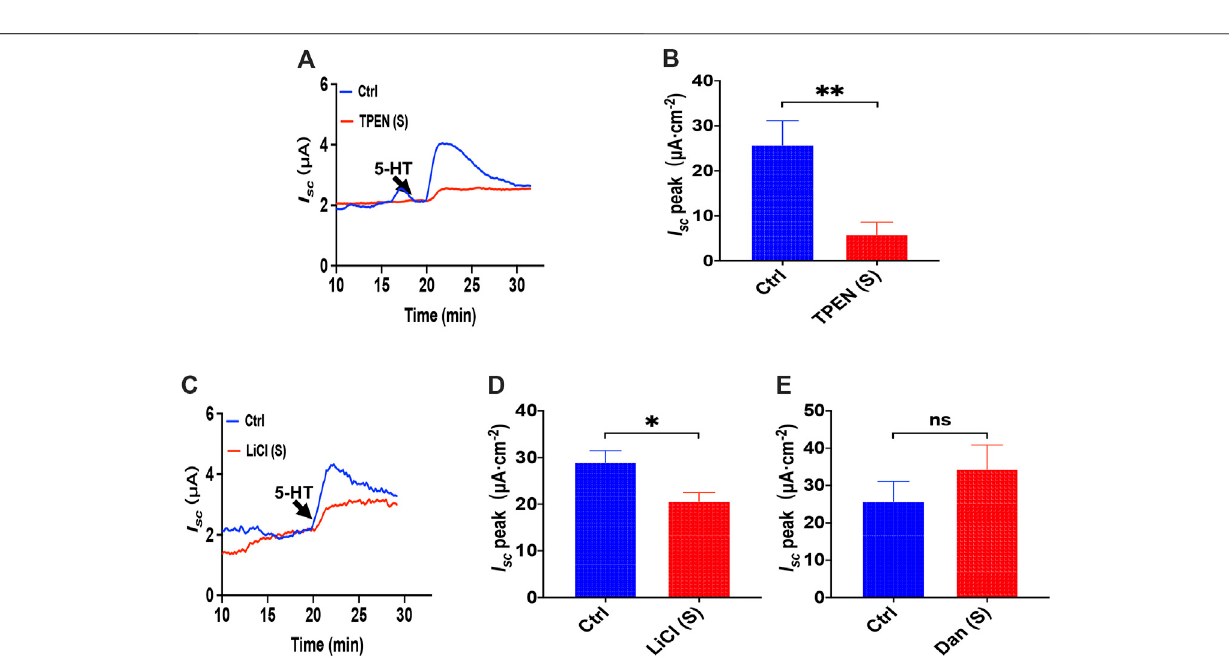
FIGURE8| TheERCa 2+ storeandIP 3 /Ca 2+ signalingin5-HT-inducedintestinaliontransports. (A,B) 5-HT-evokedduodenal I sc afterTPEN(1 mM, n (cid:2) 6)addedto serosal(s)side. (C,D) 5-HT-evoked I sc afterLiCl(30 mM, n (cid:2) 6)wasaddedtotheserosal(s)side. (E) 5-HT-evoked I sc afterdantrolene(Dan,100 μ M, n (cid:2) 6)wasaddedto the serosal side. Ctrl represents the control without drug treatment. Results are presented as mean ± SE. NS, no signi fi cant differences, * p < 0.05, ** p < 0.01 vs. corresponding control by Student ’ s unpaired, two-tailed t-test.